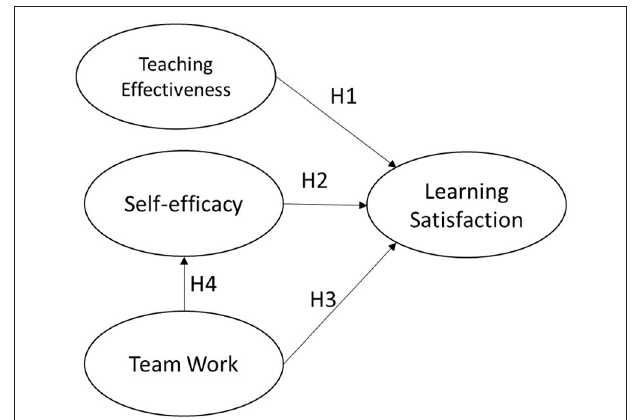
FIGURE 2 | Research